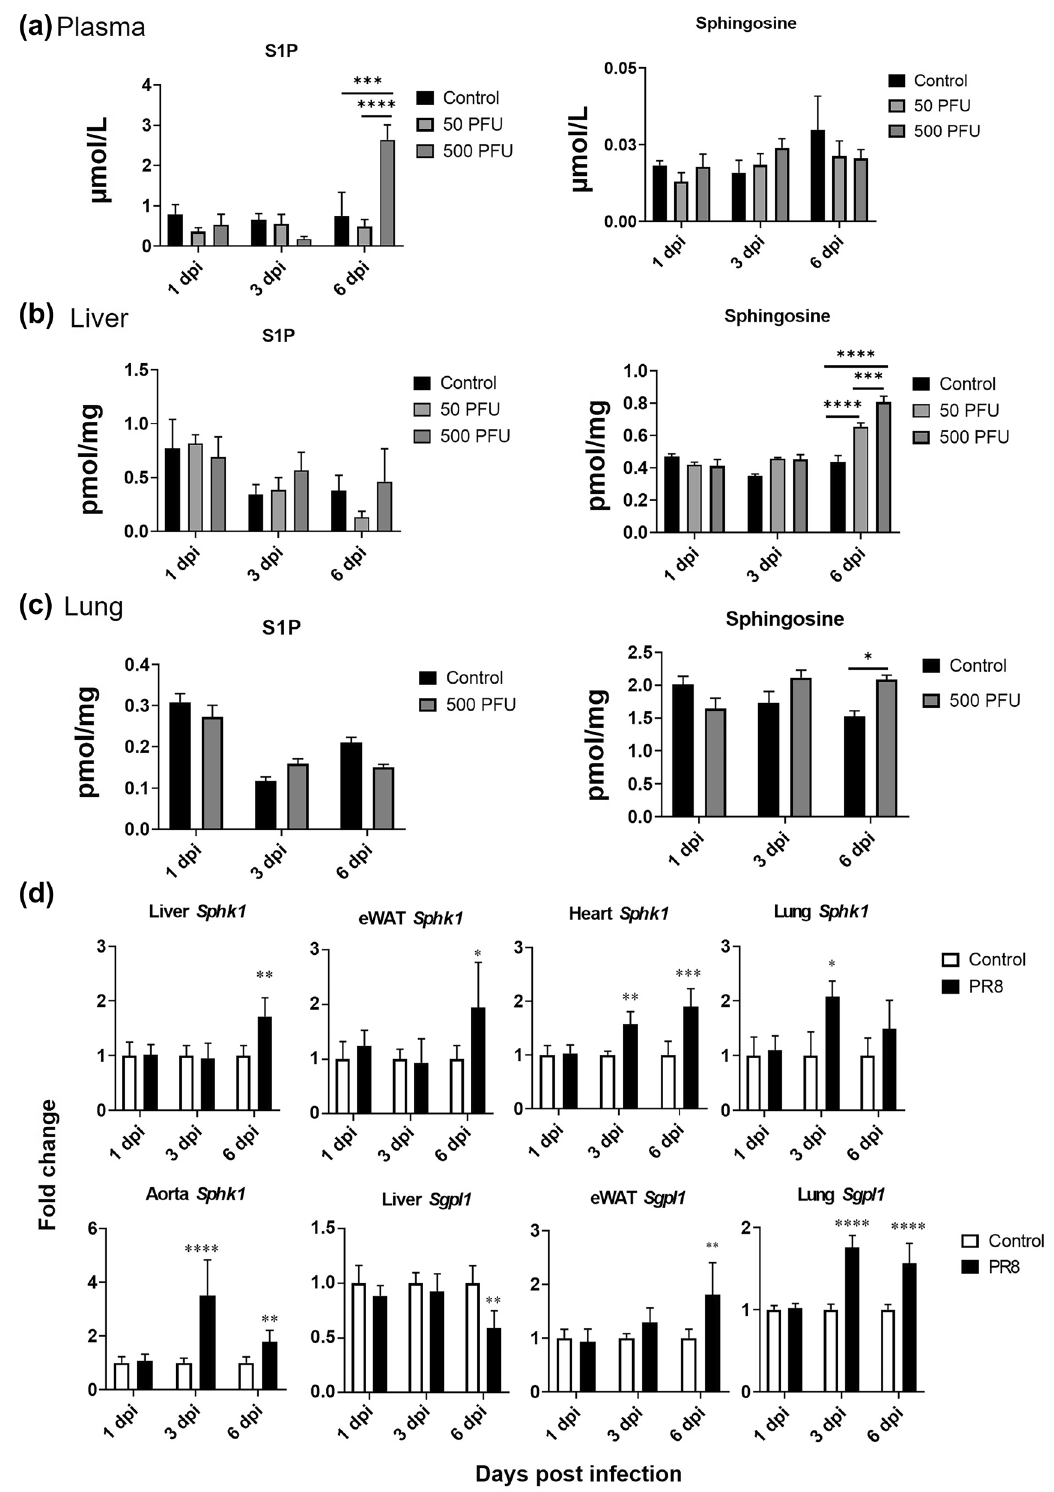
Figure 2. Concentrations of sphingolipids, gene expressions of S1P synthesis ( Sphk1 ), and hydrolysis enzymes ( Sgpl1 ) Concentrations of S1P and its precursor sphingosine in plasma ( a ), liver ( b ), and lung ( c ) of PR8 virus infected mice (n = 5 each, mean ± SE, Two-way ANOVA with Tukey’s multiple comparison test). Mice were intranasally inoculated with PBS alone or PBS comprising PR8 virus (500 PFU), and liver, e-WAT, lung, heart, and aorta samples were collected at 1, 3, and 6 dpi. Expressions of target genes ( d ) normalized with that of 18S are presented as fold changes relative to those of the control mice at each time point. Bars represent means ± SEM of 7 or 8 (liver, lung, aorta) or 3 or 4 (e-WAT, heart) animals. White and black bars indicate data from control and PR8 virus-infected mice, respectively; * p < 0.05, ** p < 0.005, *** p < 0.0005, 2way-ANOVA on ddCt, control vs. PR8 virus-infected mice at each time